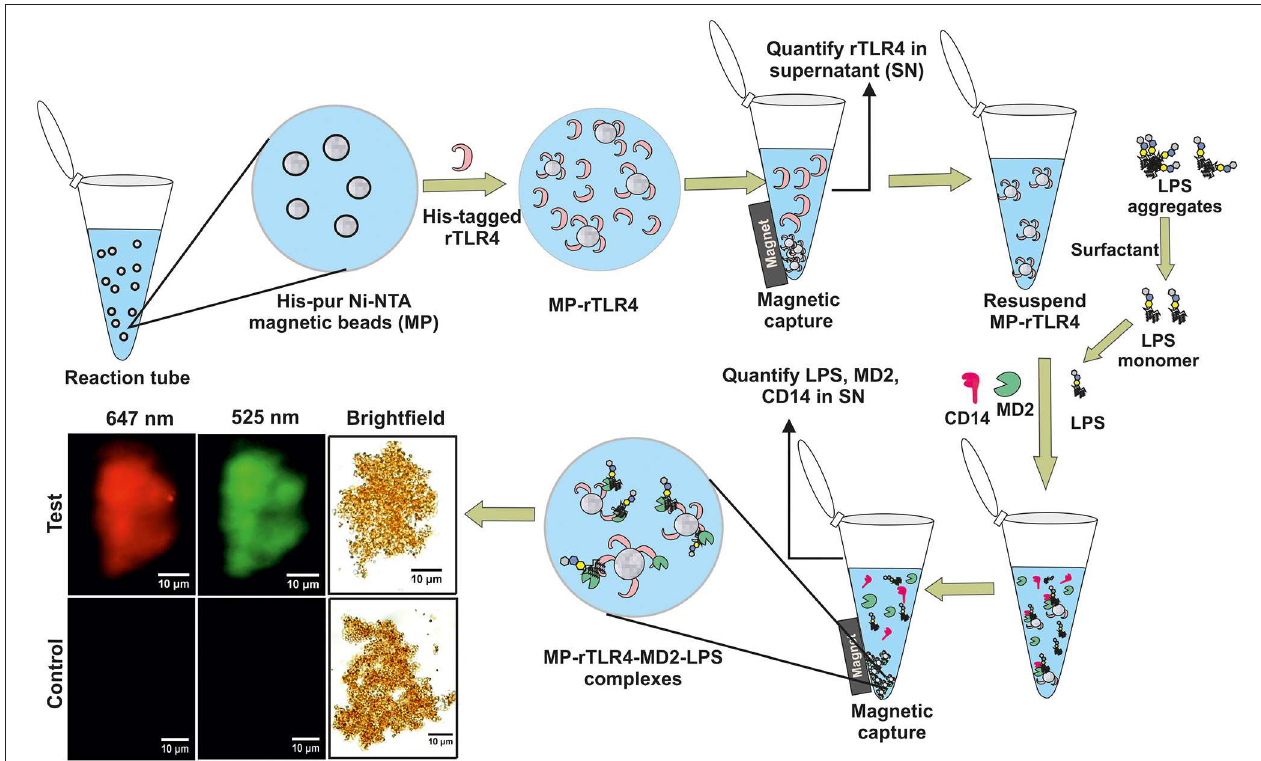
FIGURE 1 | A schematic representation of our experimental approach showing rTLR4 conjugation to magnetic nanoparticles and its in vitro complexation with LPS in the presence of free forms of MD2 and CD14 co-receptors. The bottom left panel shows the actual optical micrographs of MP-rTLR4-MD2-LPS (test) and MP-rTLR4 (control) complexes recorded in brightfield and complementary fluorescence modes at two different emission wavelengths: 525nm (green) for alexafluor-tagged LPS and 647nm (red) for alexafluor-tagged MD2. 100 mM PBS, 0.6 M NaCl, 0.05% Tween 20 and 30 mM